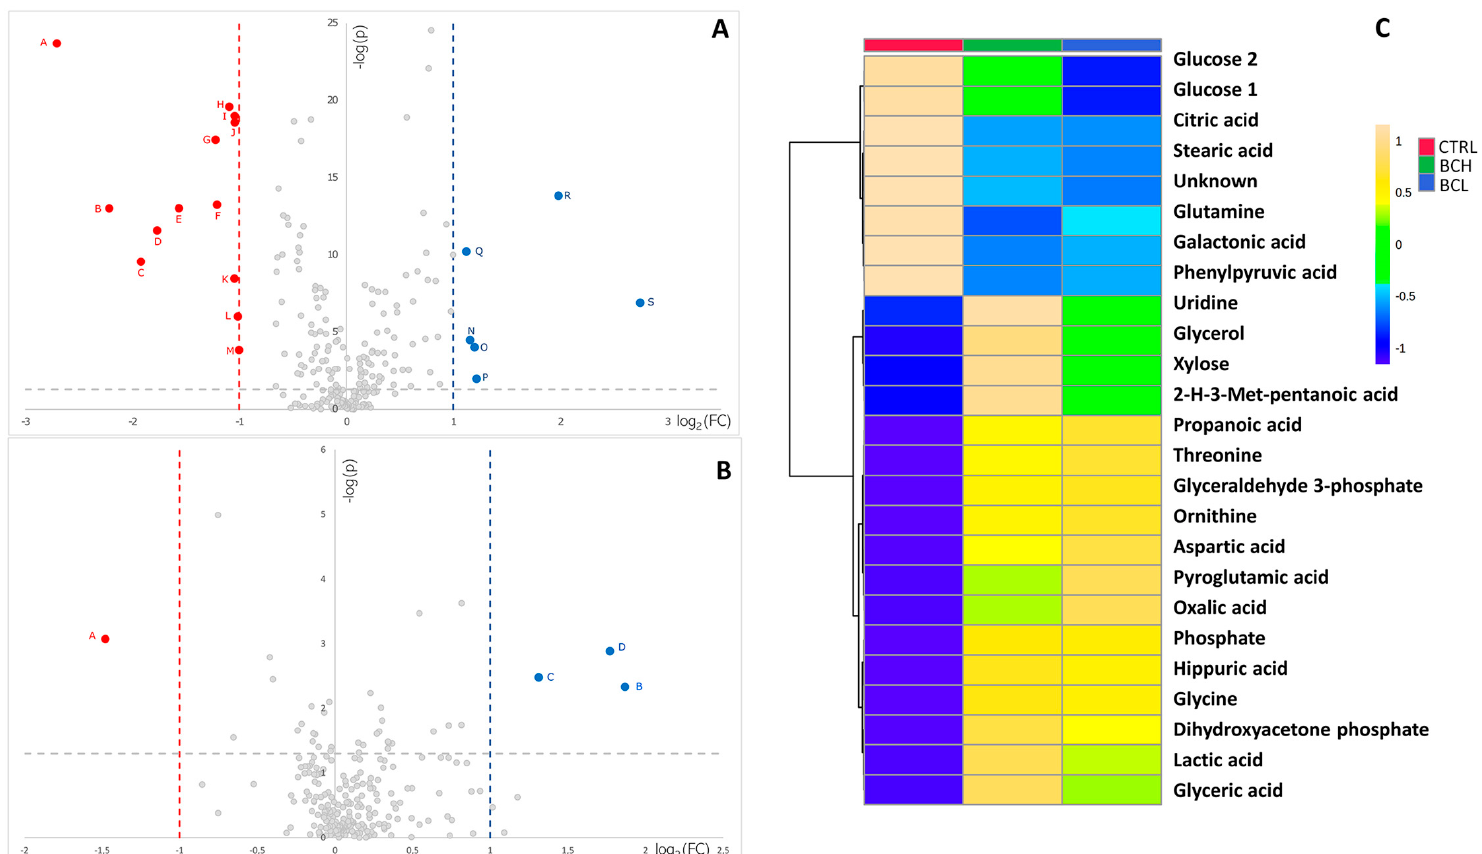
Figure 1. ( A ) Volcano plot comparing metabolite signals in healthy subjects (CTRL) and bladder cancer patients (BC): A. phosphate, B. glycine, C. diethylene glycol, D. urea, E. oxalic acid, F. pyroglutamic acid, G. propanoic acid, H. glyceraldehyde-3-phosphate, I. dihydroxyacetone phosphate, J. ornithine, K. proline, L. glutamic acid M. phenol, N. valine, O. phenylalanine, P.1-methylhypoxanthine, Q. arachidic acid, R. glutamine, S. creatinine; ( B ) Volcano plot comparing metabolite signals in high-grade (BCH) and low-grade (BCL) BC patients: A. amino malonic acid, B. valine, C. proline, D. pentanoic acid; ( C ) Heatmap of the metabolites selected by the genetic algorithm (Glucose 1 and Glucose 2 represent two different derivatization products obtained by the sylanization